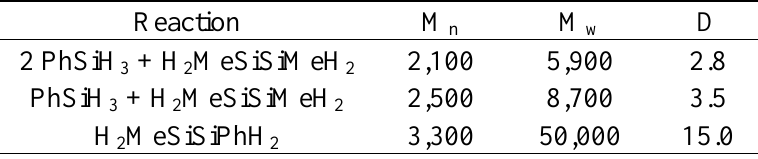
Table 1. Molecular weights of polysilanes determined by